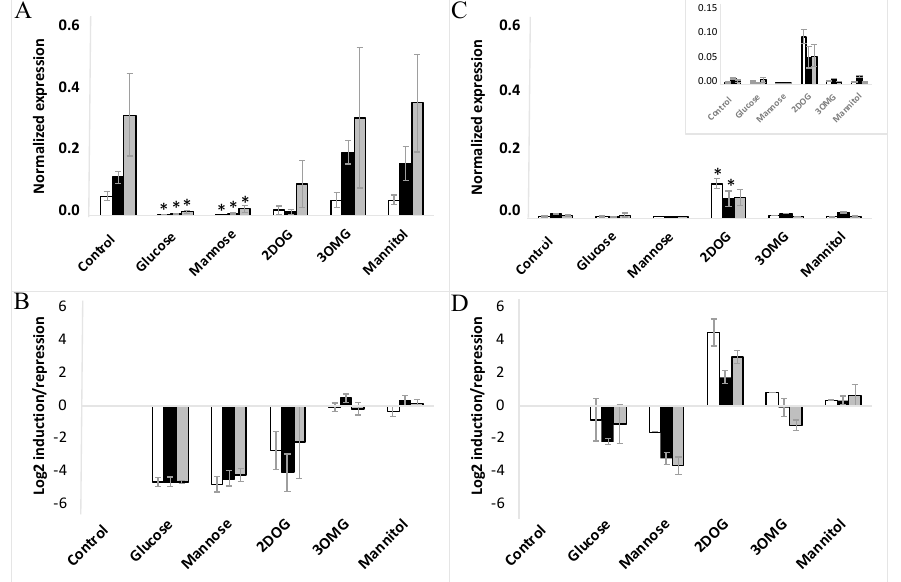
Figure 8. Expression of VvHT5 in embryogenic cells ( A , B ) and non-embryogenic cells ( C , D ) in response to different treatments with glucose, mannose, 3OMG, mannitol (all applied at 10 mM concentration), and 2DOG (0.9 mM). □ -WT; ■ -VvMSA-OE; ■ -VvMSA - RNAi. The embryogenic cells and the non-embryogenic cells were collected after 8 days of subculture and incubated for additional 24 h in their respective minimal media, i.e., GM° minimum (EC) and Gb minimum (NEC). Sugar effectors were added afterwards and the treatment of EC was extended for 6 h, while that of NEC for 24 h. The gene expression of VvHT1 is normalized to that of the housekeeping gene VvActin and reported to the control condition used to calculate the ratio of induction/repression. Normalized expression ( A , B ) and induction/repression ( C , D ) are calculated by the methods of Δ Ct and 2- ΔΔ Ct, respectively. The presented results correspond to the mean values of three independent biological experiments (±SEM). The asterisks denote the groups that were found significantly different by Kruskal–Wallis test (* p < 0.05) .